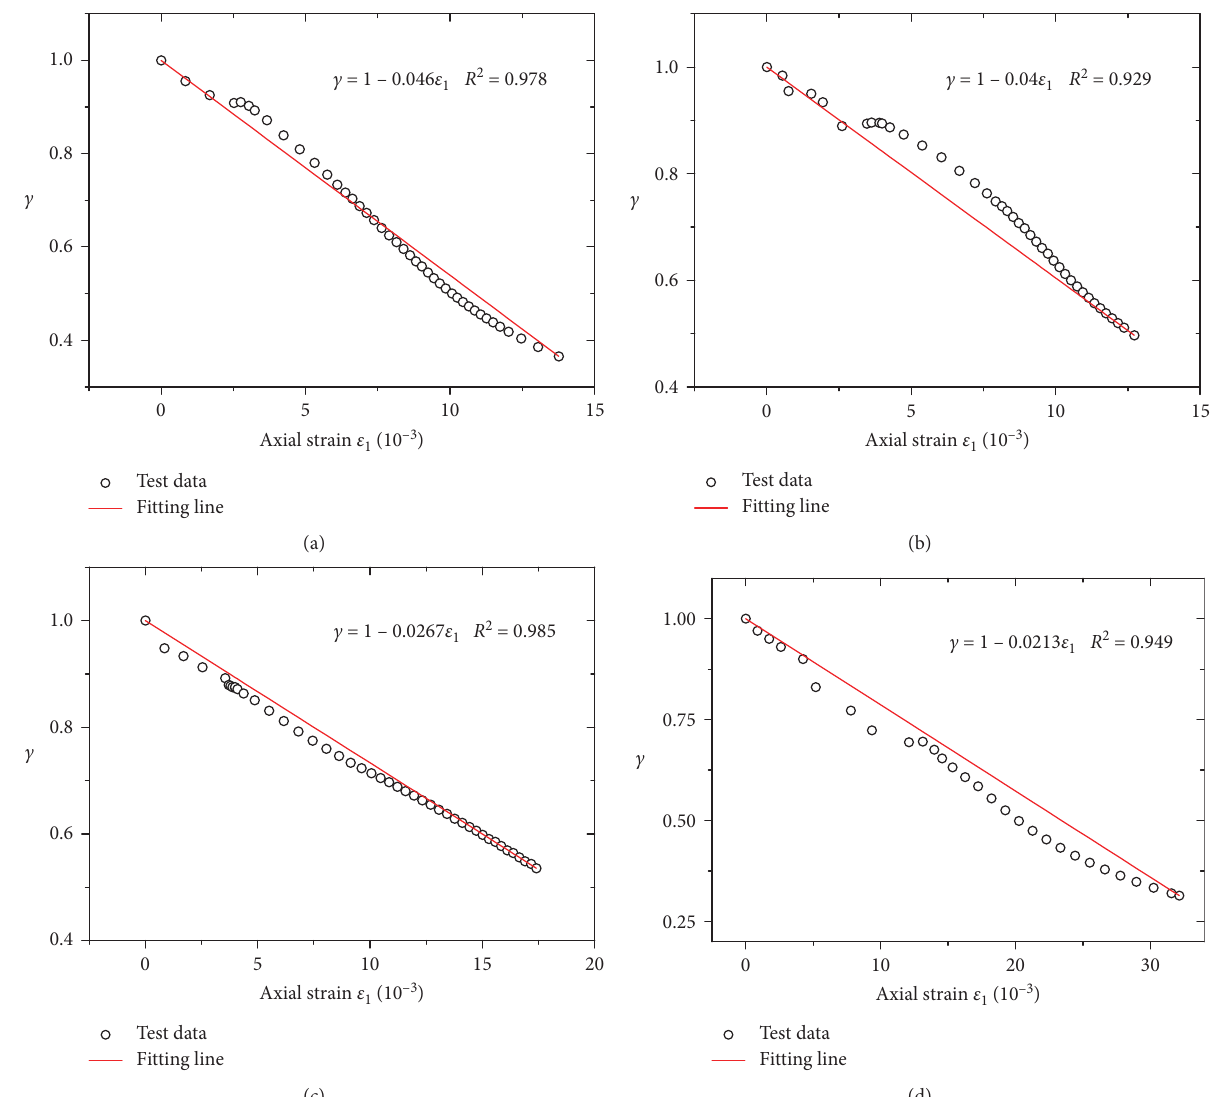
Figure 6: The relationship between and strain: (a) the porosity is 13.90% when the saturation is 0. (b) The porosity is 15.27% when the saturation is 1. (c) The porosity is 14.27% when the saturation is 0. (d) The porosity is 19.56% when the saturation is